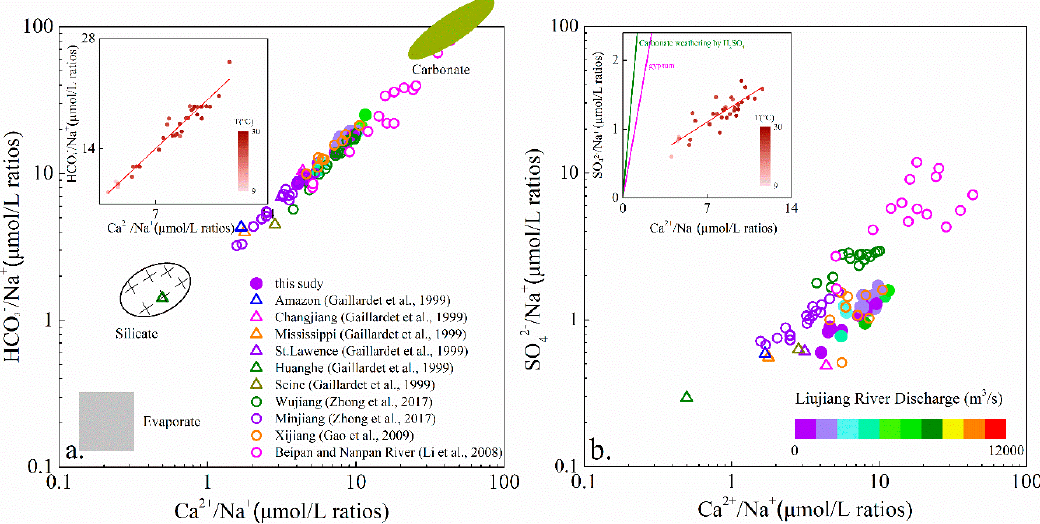
Figure 6. Plots of (a) Ca 2+ /Na + versus HCO 3- /Na + and (b) Ca 2+ /Na + versus SO 42- /Na + for the Liujiang River waters in a hydrological year [1,4,9,11,23].